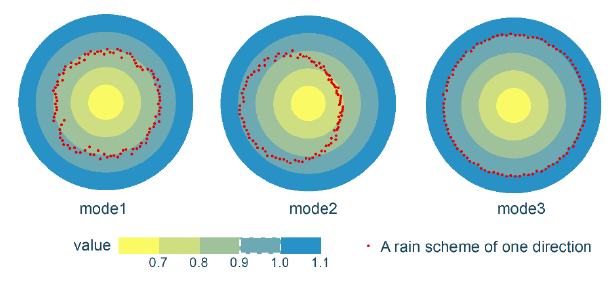
Figure 4. Distribution of I fp s for typical modes.